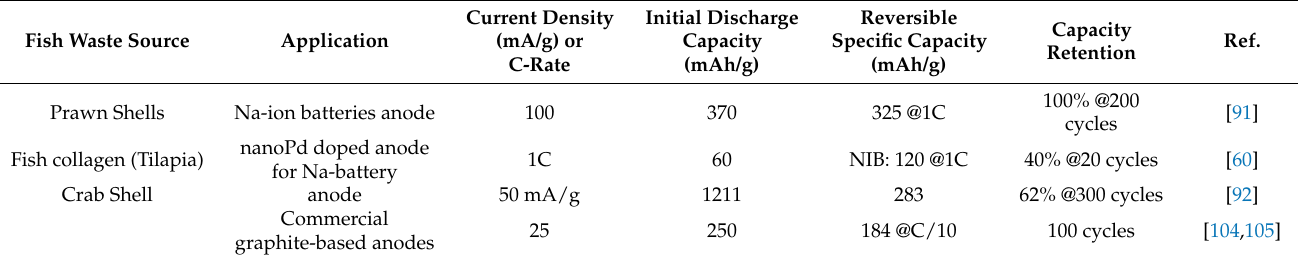
Table 2. Performance of porous carbon-based materials obtained from fish industry waste for Na-ion batteries. Fish Waste